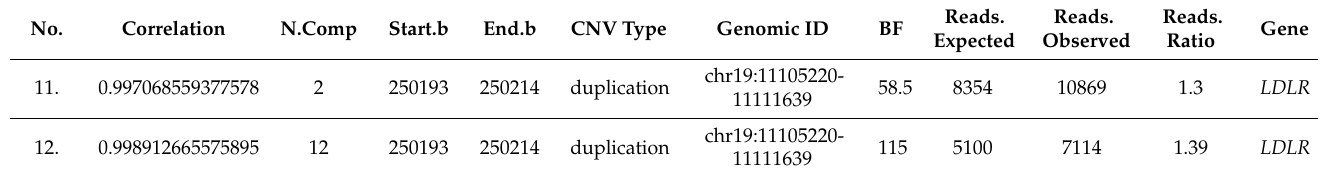
Table 2. Results obtained with the DECoN program. The following columns indicate: Correlation— the maximum correlation between the test sample and any other sample in the full set of BAM files, N.comp—the number of samples used as the reference set, Start.b—the number of the first exon in the call from the analyzed BED file, End.b—the number of the last exon in the call from the analyzed BED file, CNV type—type of copy number variation change, Genomic ID—genomic coordinates of detected variant according to GRCh38, BF—the Bayes factor associated with the call, Reads.expected—the number of expected reads under the probabilistic model, Reads.observed—the number of observed reads, Reads.ratio—the ratio of observed to expected reads and Gene